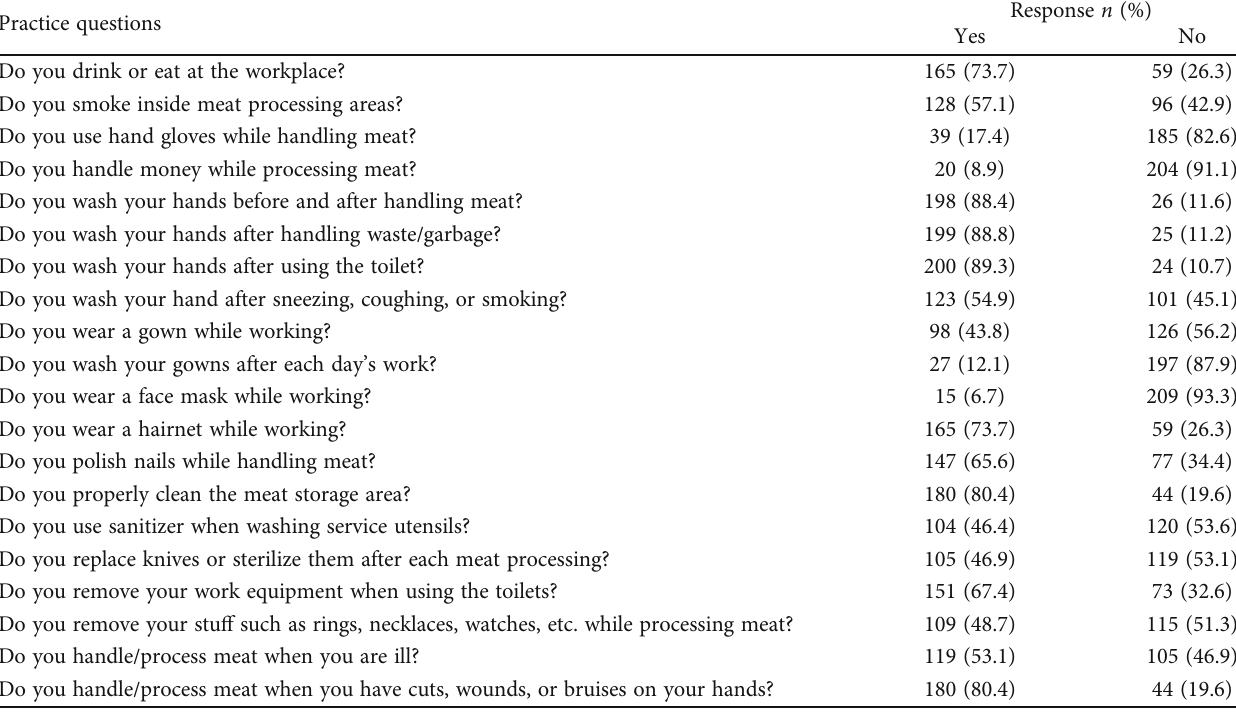
Table 2: Meat handling practice of meat handlers in butcher shops in North Shewa Zone ( n = 224 ). Practice questions